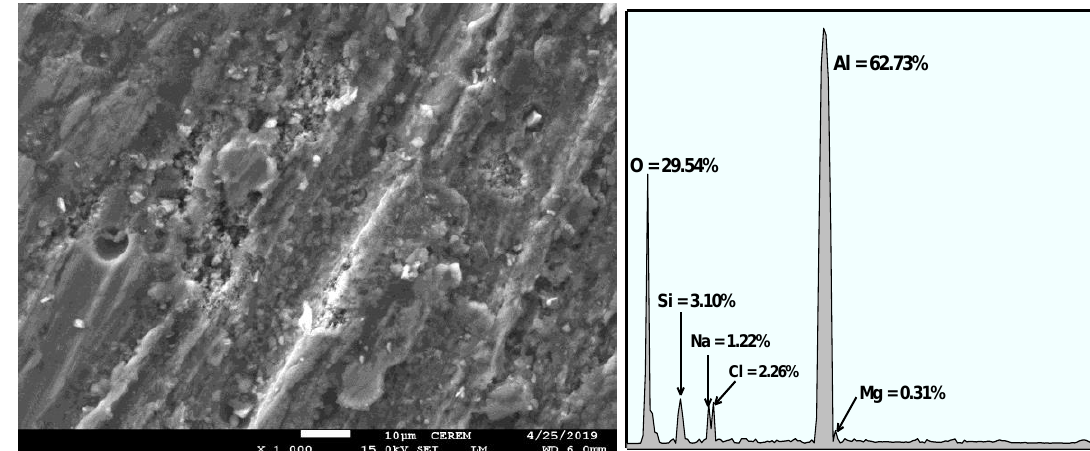
Figure 10. The SEM and EDX investigations for the alloy that was extruded at 500 °C after 24 h exposure in NaCl solution at −680 mV that was applied for 40 min.